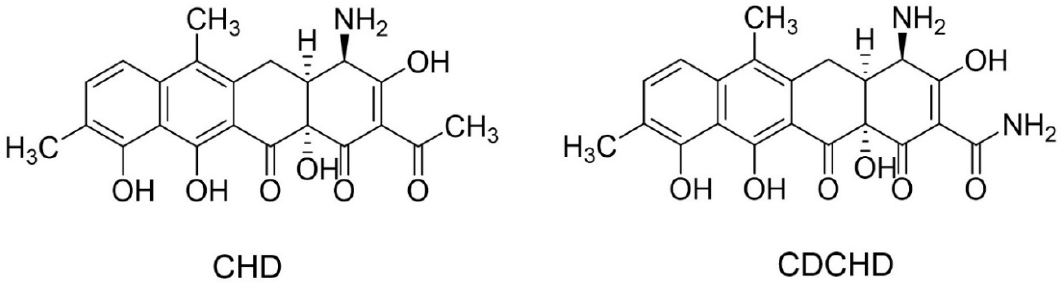
Figure 1. Chemical structures of chelocardin (CHD) [28] and its amidated derivative 2-carboxamido-2-deacetyl-chelocardin (amidochelocardin, CDCHD) [15].